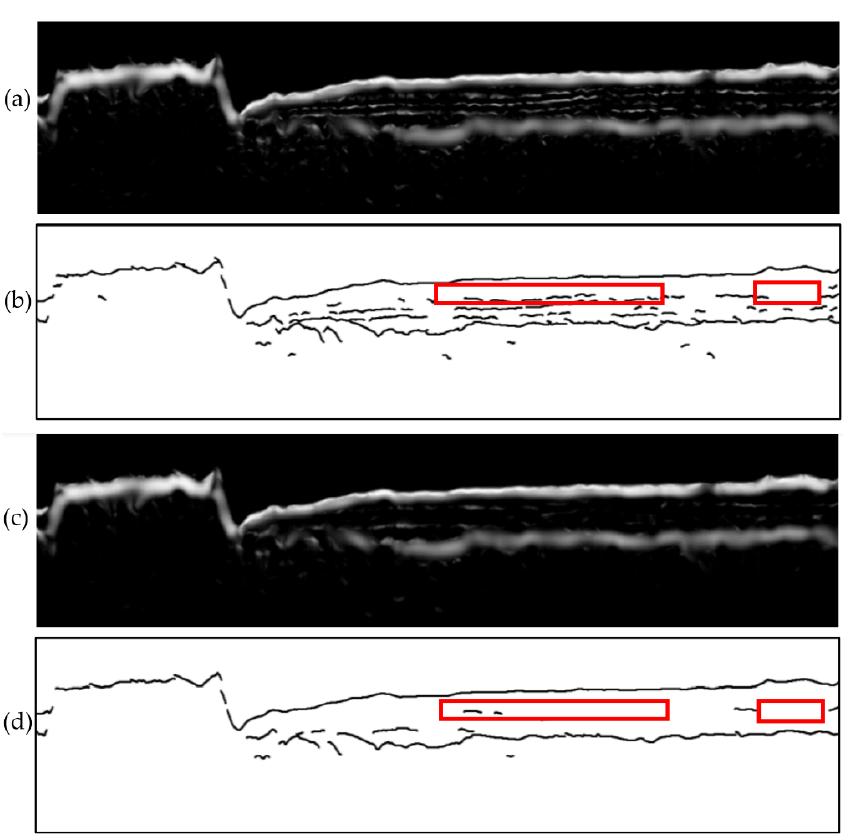
Figure 13. Results using the FrangiV method. ( a ) shows the filtered result using the FrangiV method with small scale parameter settings. ( b ) shows horizons picked from ( a ). ( c ) shows the filtered result using the FrangiV method with large scale parameter settings. ( d ) shows horizons picked from ( c ). Table 2. Analysis of the picked horizons in Figure 13b.